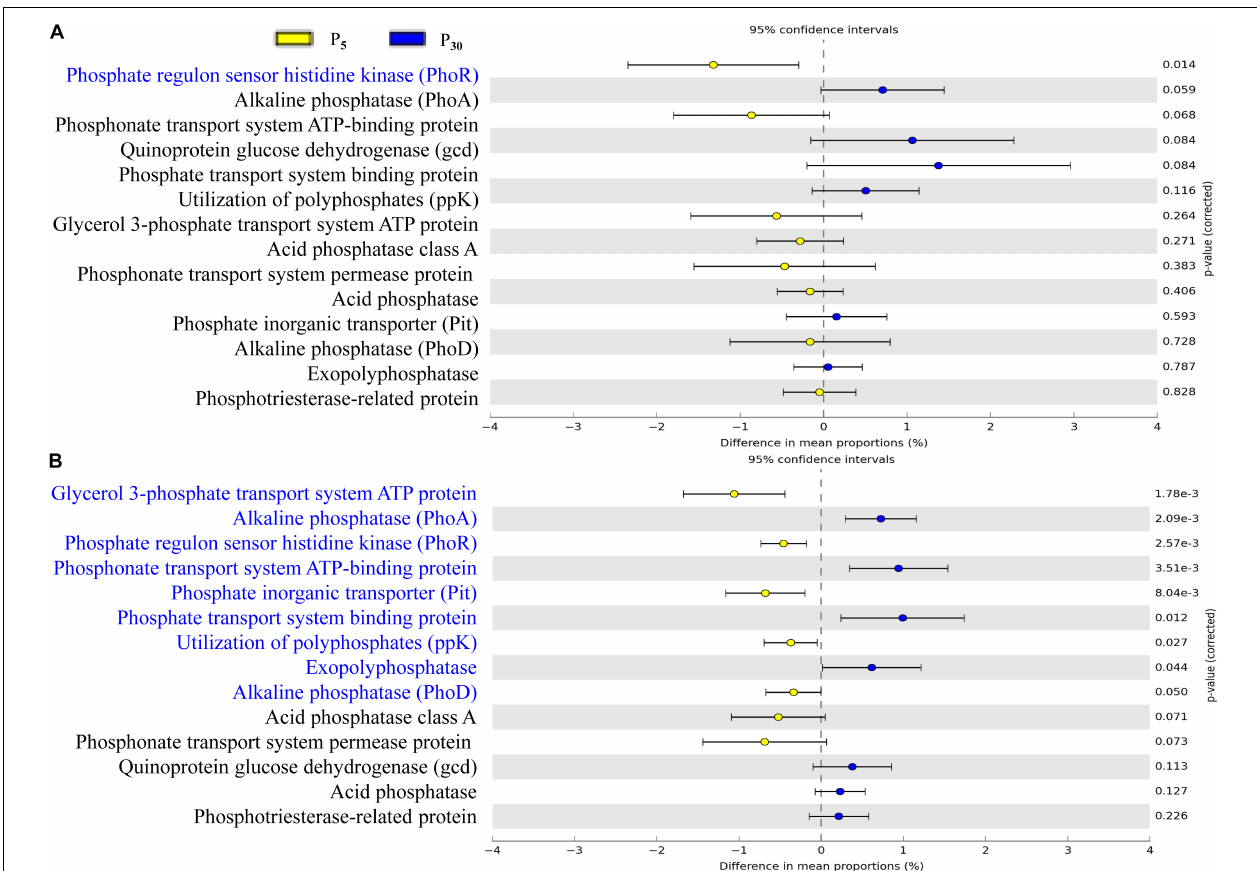
FIGURE 7 | Statistical comparison (Student’s t -test) between the predicted functions in (A) maize and (B) clover grown at P 5 vs. P 30 in rhizoplane bacterial OTUs relevant to P metabolism based on the KO abundance database using the Benjamini–Hochberg P -value correction ( P < 0.05).